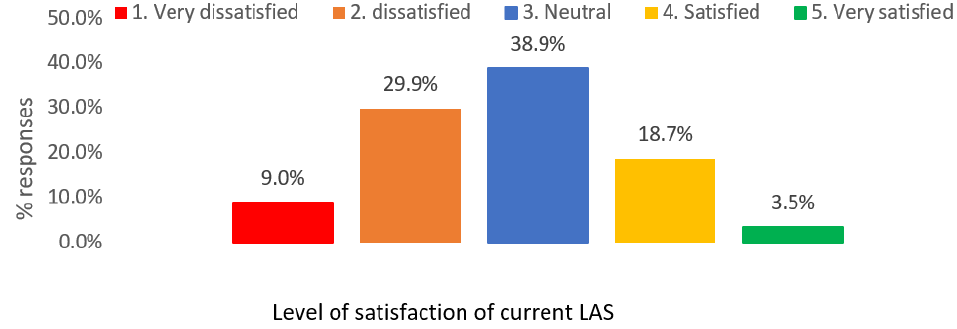
Figure 9. Descriptive statistics of the level of satisfaction.